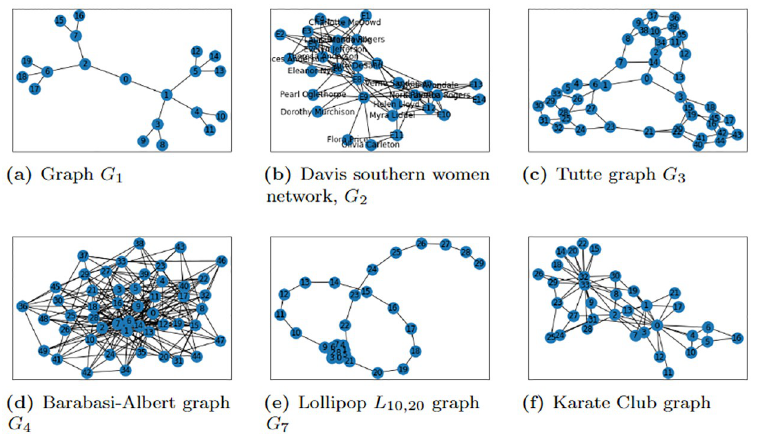
Fig 2. Large graphs considered. (a) Graph G 1 , (b) Davis southern women network, G 2 (c) Tutte graph G 3 , (d) Barabasi-Albert graph G 4 , (e) Lollipop L 10,20 graph G 7 , (f) Karate Club